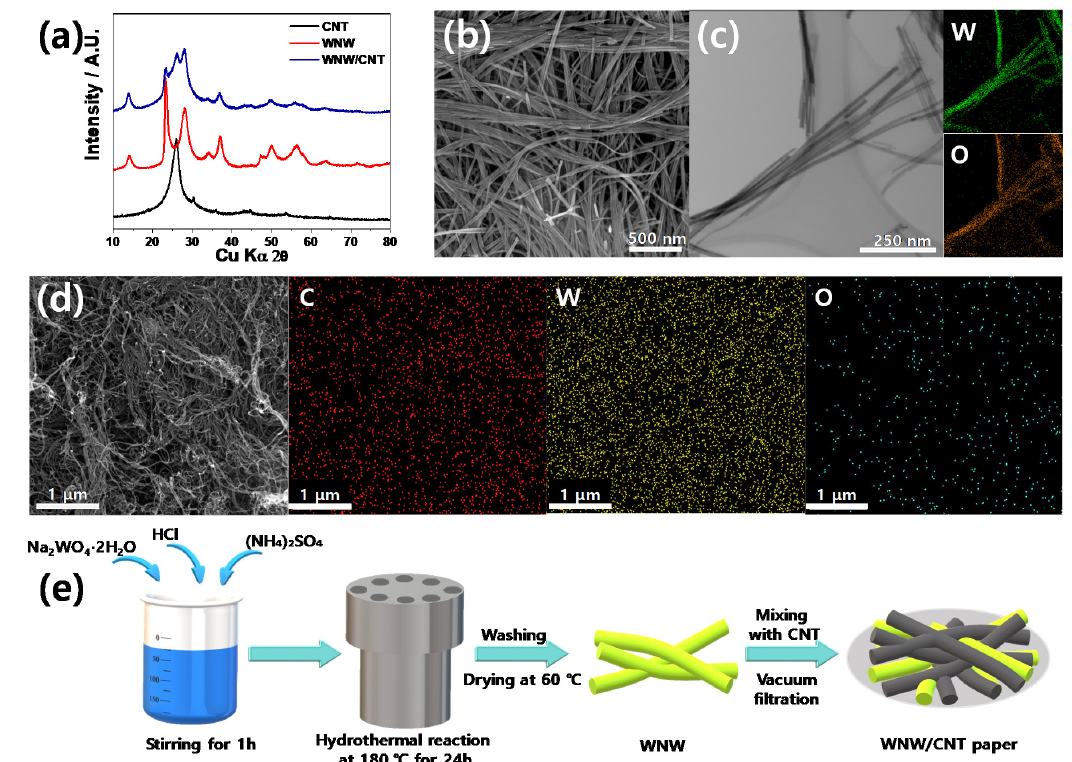
Figure 1. ( a ) XRD patterns of carbon nanotube (CNT), WO 3 nanowires (WNW), and WNW/CNT. ( b ) SEM and ( c ) TEM image of WNW. ( d ) SEM images of WNW/CNT interlayer with EDS mapping images of carbon, tungsten, and oxygen. ( e ) Synthesis of the WNW/CNT interlayer.